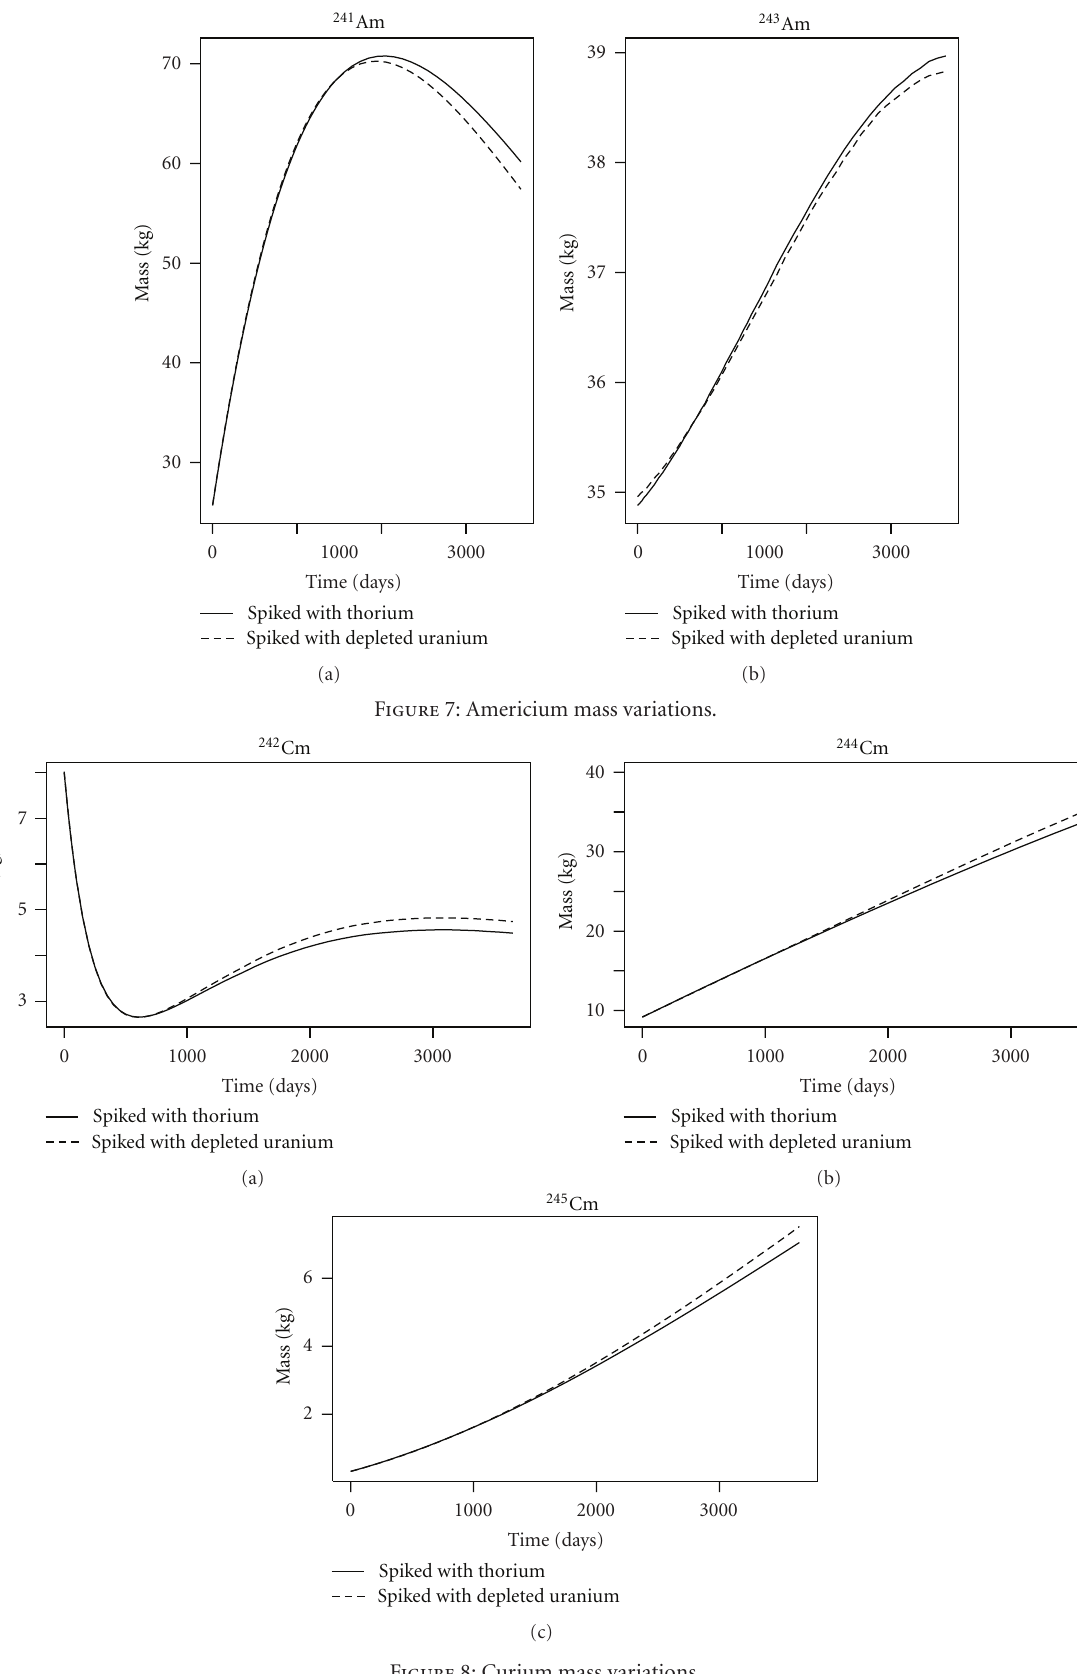
Figure 7: Americium mass variations.